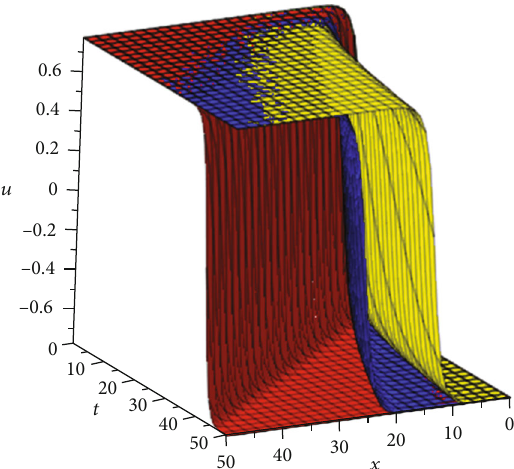
Figure 2: 3D plot of solution (27) for values of α = β = 1 , and k = 1, ρ = 2, c = − 1 : 2, C 4 = C 5 = 1 .